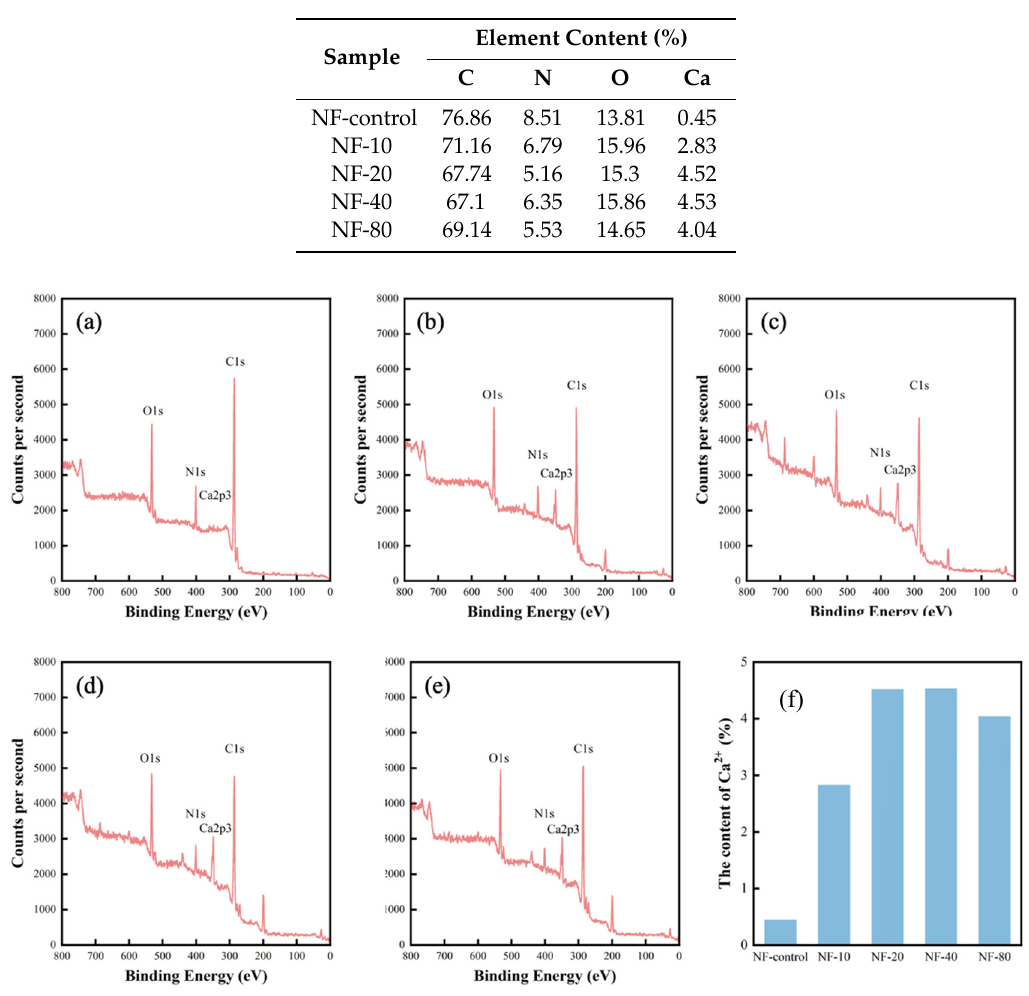
Figure 4. XPS spectra of the thin-film composite nanofiltration with different concentrations CaCl 2 added in the post-treatment: ( a ) NF-control, ( b ) NF-10, ( c ) NF-20, ( d ) NF-40, ( e ) NF-80; ( f ) the element of Ca 2+ for different membranes.